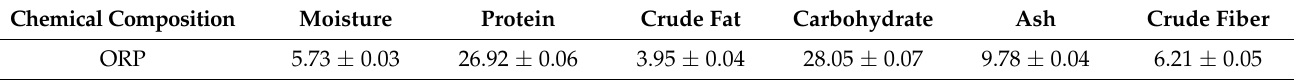
Table 2. The content and main chemical composition of ORP (%). Chemical Composition